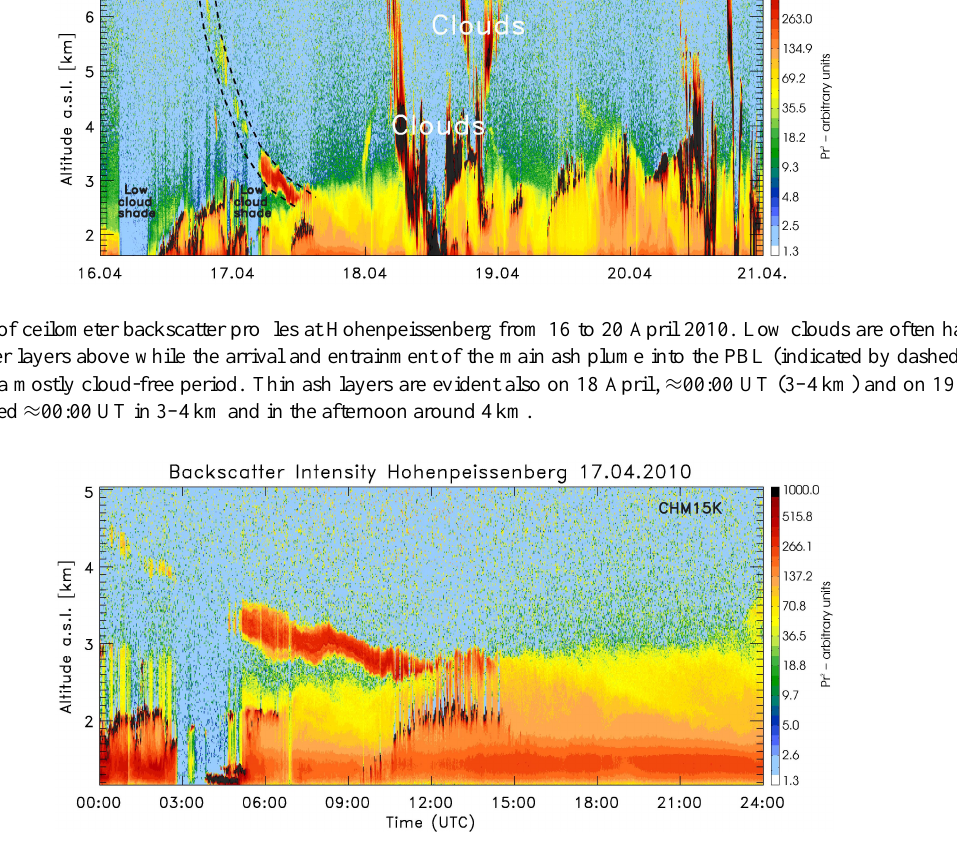
Fig. 2. Range corected backscatter intensity section obtained from the Hohenpeissenberg ceilometer on 17 April. The descent of the ash plume during morning hours in about 4–5km is evident, although low-level clouds partly shadowed the backscatter signal from above. The entrainment of the ash plume into the planetary boundary layer starts around local